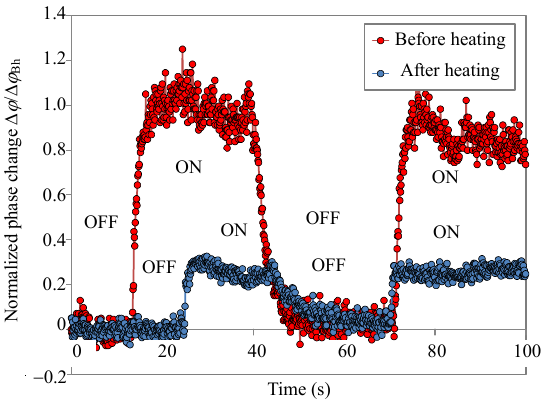
Fig. 5 Normalized phase change as a function of time for sensor before and after heating at 120 ℃ for 30 min. The is the phase change amplitude of nonpreheated sample at the influence of IPA / N 2 stream. The sensor comprises a waveguide with 1.2 μ m thick organic glass PMMA + DMABI-Ph6 cladding. Here the OFF state corresponds to pure N 2 stream, while the ON state to the mixed IPA / N 2